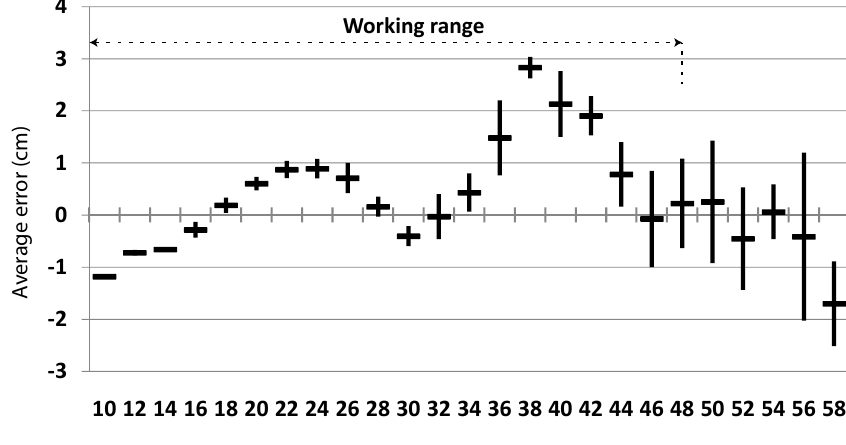
Figure 6. IRsensors accuracy experiments: average error and its standard deviation. ( a ) IR front sensor (Sharp 2Y0A21); ( b ) IR lateral sensor (Sharp